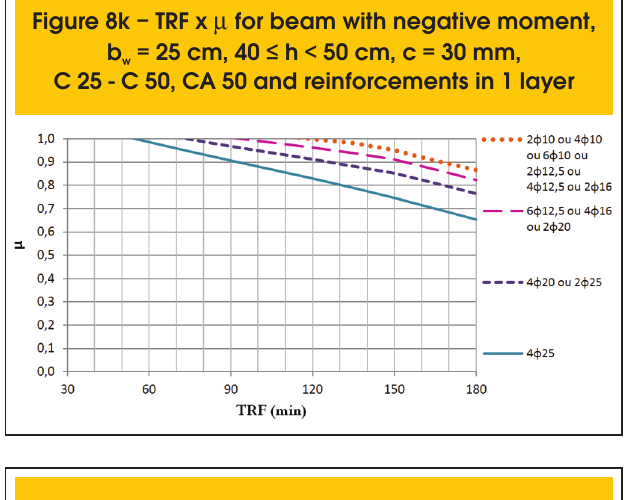
Figure 8o – TRF x m for beam with negative moment, b = 25 cm, 50 ≤ h < 60 cm, c = 40 mm, w